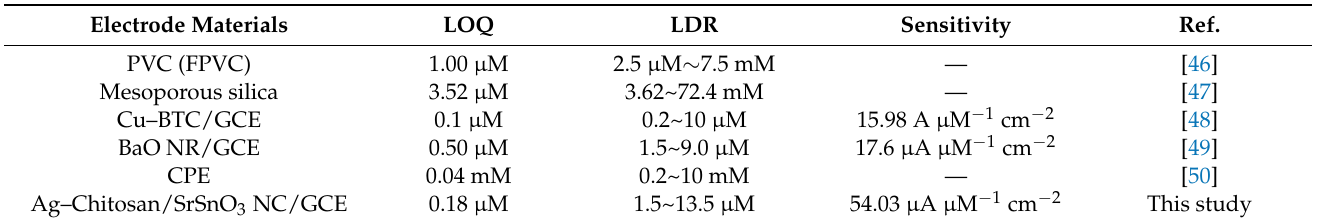
Table 1. Comparison studies of 2,6-DNP detection based on various nanocomposite materials by electrochemical approaches.